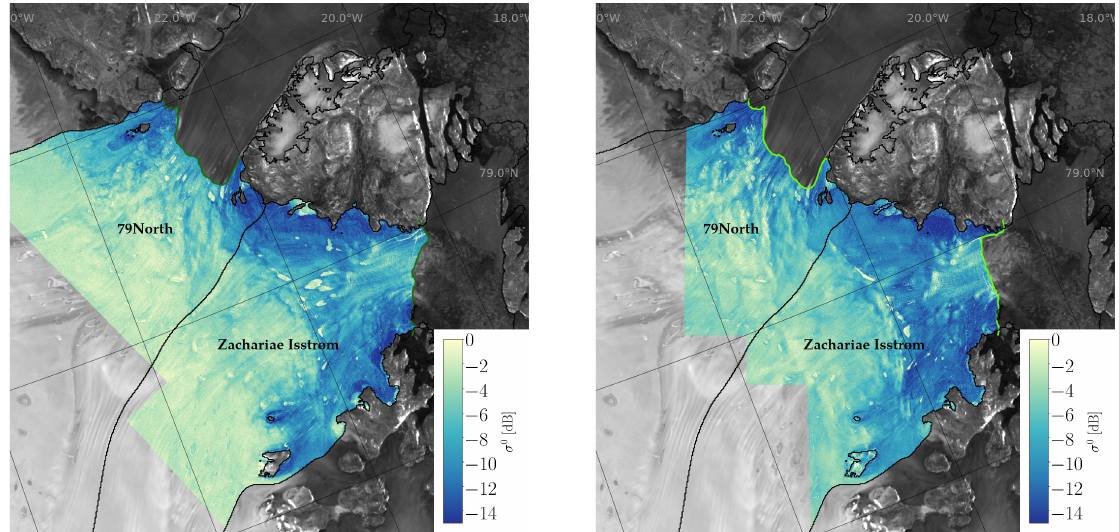
Figure 2. σ 0 mosaics for winter 2010 and winter 2013 corrected for the noise equivalent σ 0 (NESZ). In the background, the TDM global DEM backscattering